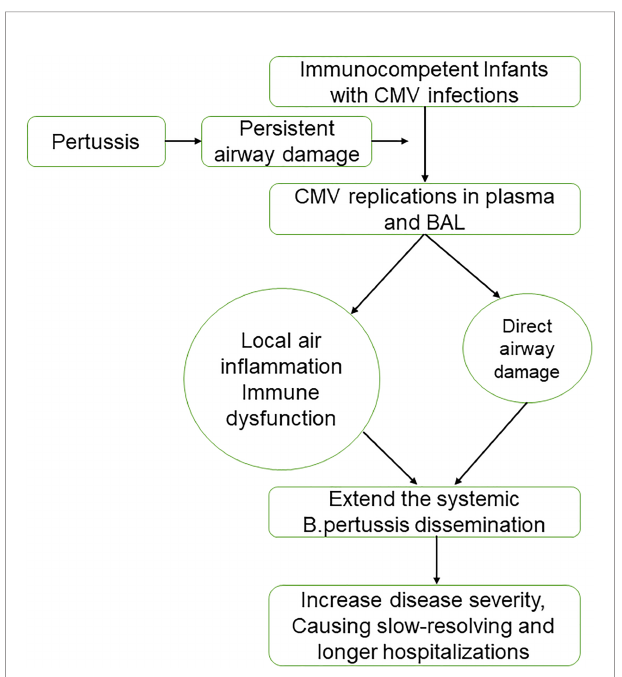
FIGURE 4 | Hypothesized model for cytomegalovirus (CMV) reactivation in infants with pertussis. BAL, bronchoalveolar